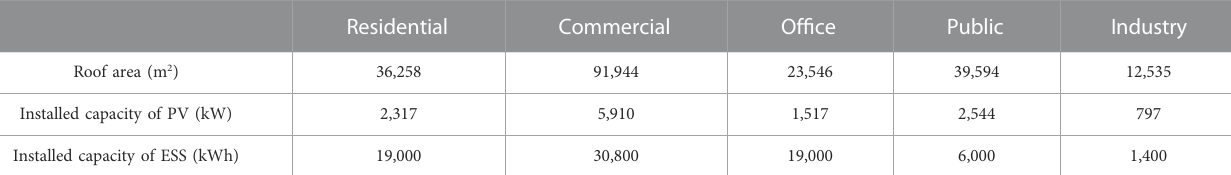
TABLE 3 Installed capacity of PV and